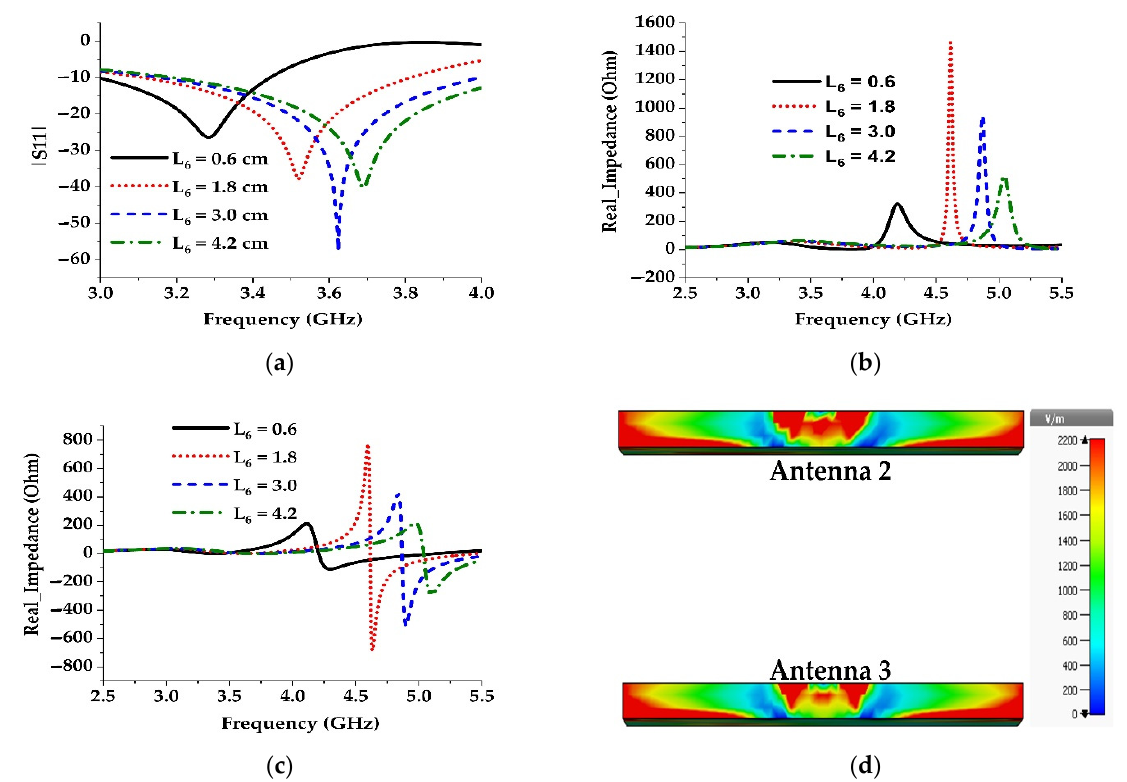
Figure 9. Variation of reflection coefficients and real and imaginary impedance values with different gap widths. ( a ) Reflection coefficients; ( b ) Real impedances; ( c ) Imaginary impedances; ( d ) Simulated electric field distribution in the cross-section of Antenna 3 and Antenna 4.